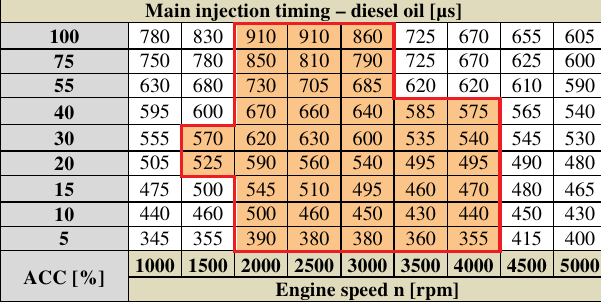
Table 4. Control algorithm of opening time of Diesel oil injectors for Main dose at dual fuel supply of the engine